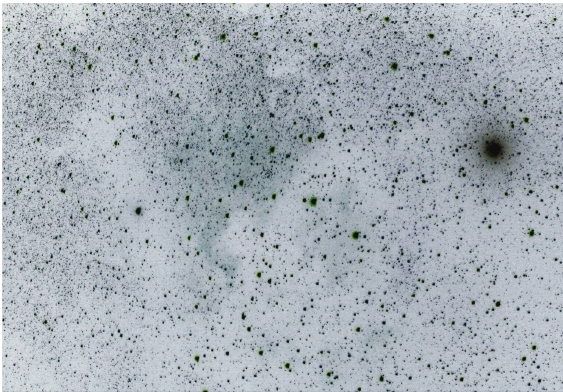
Figure 8: An example of image taken by Canon EOS 350D digital CCD camera with nonfish eye lens Soligor 2.8/105 mm (converted to negative) at Sonneberg Observatory. Then the limiting magni- tude amounts to 15 over a smaller FOV of order of 10 × 10